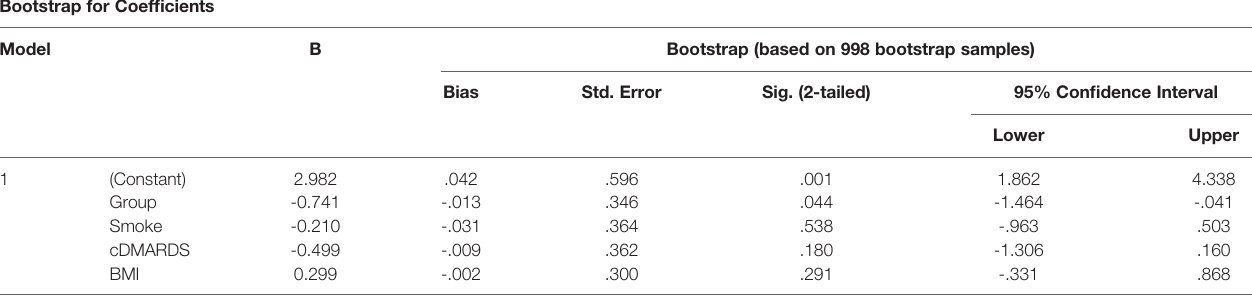
TABLE 3 | Bootstrapping analysis for pSTAT3 in CD4+ Tfh cells. Bootstrap for Coef fi cients